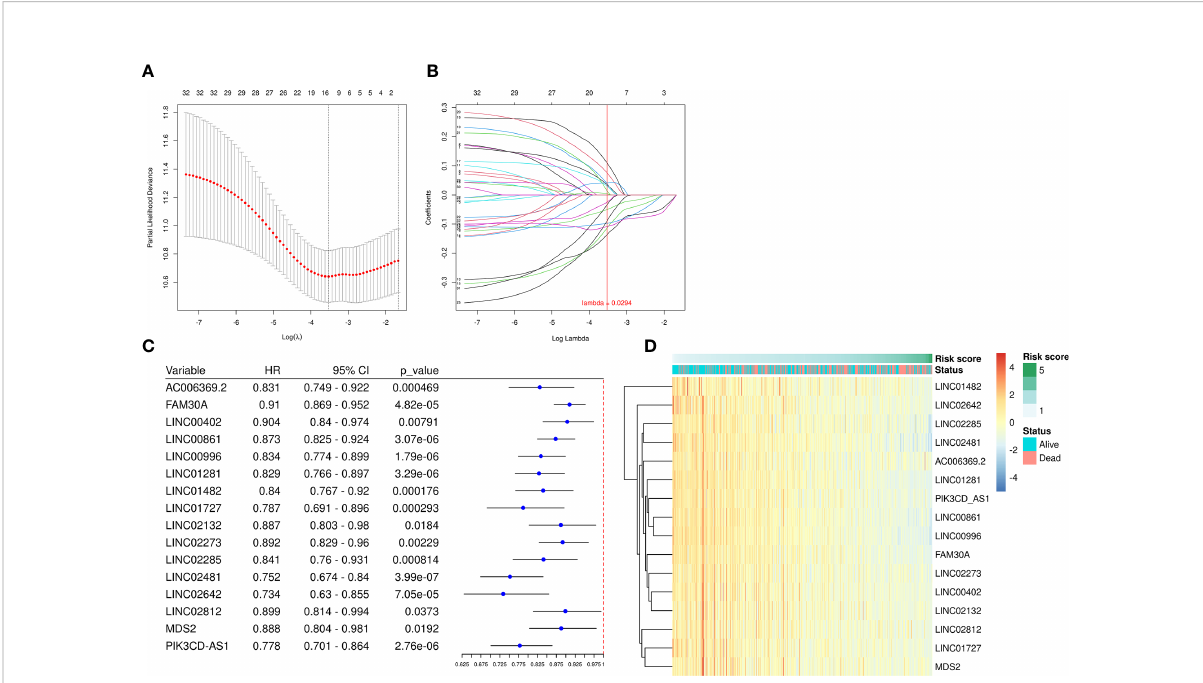
FIGURE 2 A prognostic risk model was established using LASSO regression and Cox regression analyses. (A) Cross-validation was used to tune the parameter screening in the LASSO regression model. (B) The LASSO coef fi cient pro fi les for the 32 DEfrLncRNAs. (C) Forest plots of HRs and P - values of selected DEfrLncRNAs using univariate Cox regression analysis. Sixteen of the DEfrLncRNAs were found to be prognostic factors, and all are protective factors in SKCM with HR< 1. (D) Distribution heat map of the 16 DEfrLncRNA expressions, RS, and clinical status (alive or dead) relative to